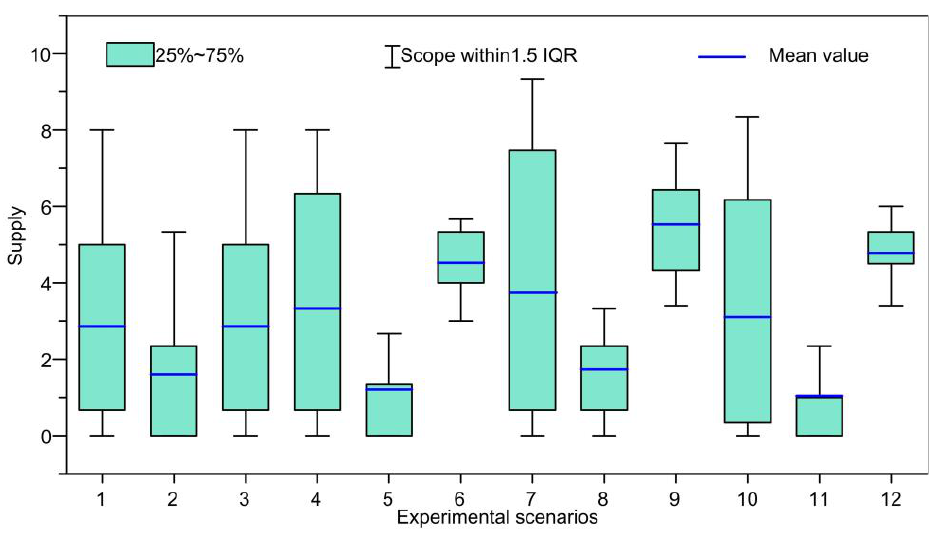
Figure 2. Supply analysis in 12 scenarios.